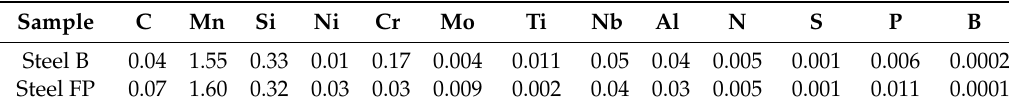
Table 1. Chemical compositions of the bainitic and ferrite/pearlite X65 grade linepipe steels in wt %.